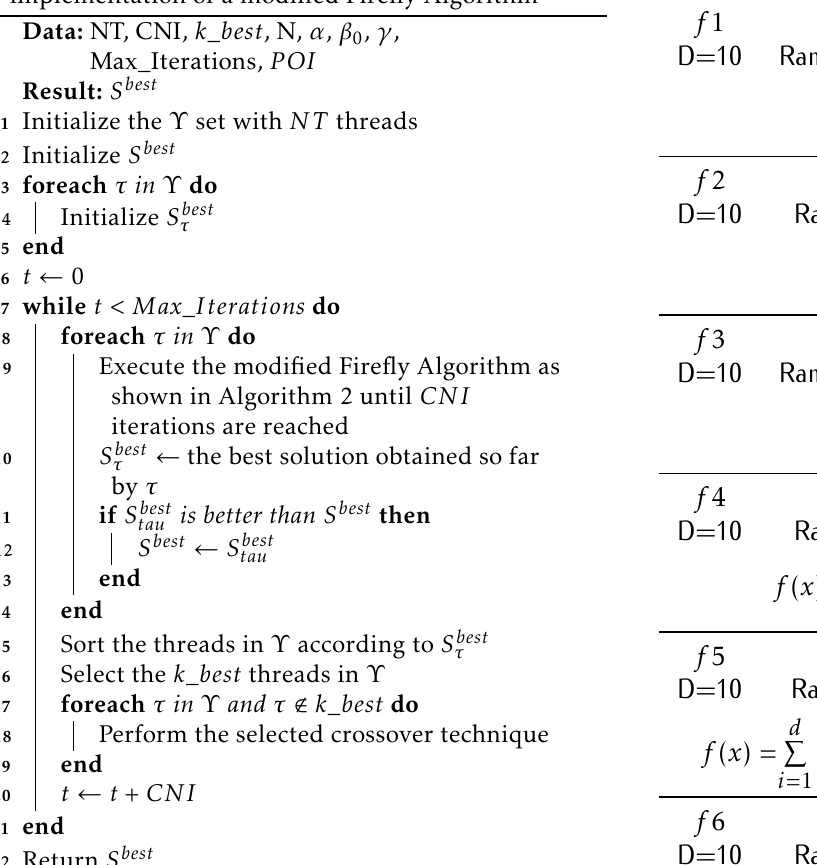
Algorithm 3: Pseudocode of the Multi-threaded implementation of a modified Firefly Algorithm